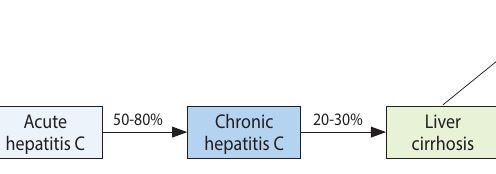
Figure 1. Natural history of hepatitis C virus